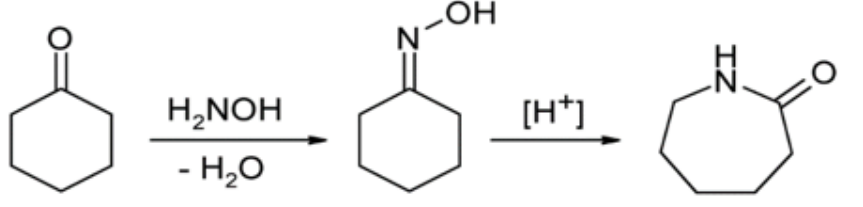
Figure 1. ε -caprolactam produced from cyclohexanone via the oxime by a reaction with hydroxy- lamine and Beckmann transposition.